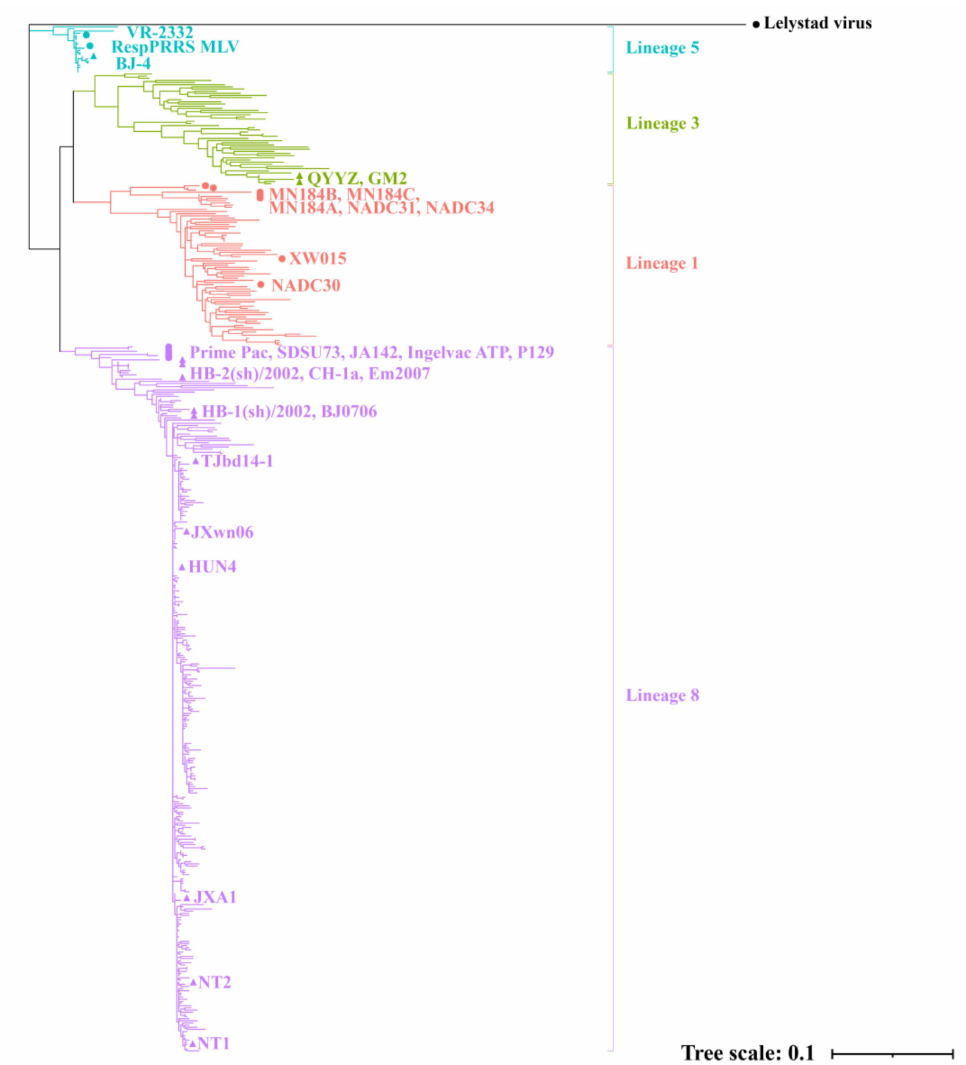
Figure 1. Phylogenetic tree based on PRRSV ORF5 genes. Type 1 Lelystad virus is set as outgroup reference, and type 2 lineage 1, 3, 5, and 8 are represented in orange, green, blue, and purple, respectively. Reference strains are marked as a triangle (for Chinese strains) and circle (for reference strains from other